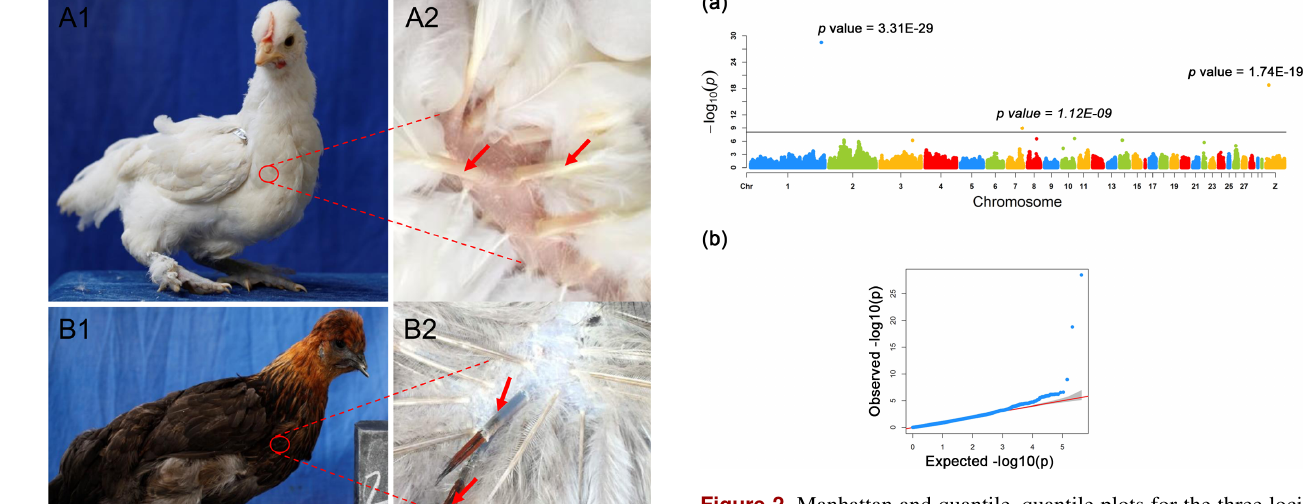
Figure 2. Manhattan and quantile–quantile plots for the three loci identified across the chicken genome. (a) The negative log10 P val- ues of SNPs transformed from a genome-wide scan were plotted against positions on the chromosomes under FarmCPU models. The three significant associated SNPs surpassed the Bonferroni thresh- old (horizontal gray lines) for the plumage trait using the FarmCPU method. (b) The quantile–quantile (QQ) plot assessed the negative base 10 logarithms of the P value observed on the Y axis, and the X axis is the expected negative base 10 logarithms of the P val- ues under the assumption that the P values follow a uniform [0, 1]